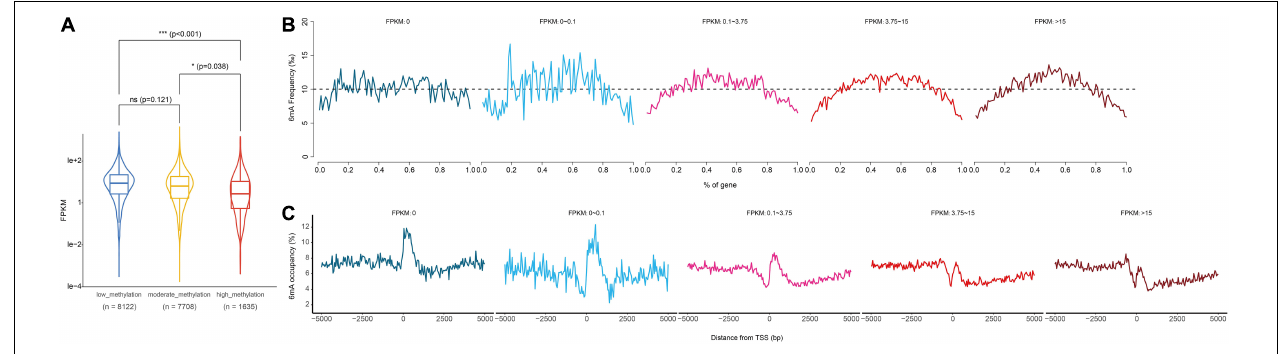
FIGURE 5 | Relationship between gene transcription and 6mA methylation. (A) Computational analysis of gene expression in different methylation levels genes. (B,C) Distribution of 6mA occupancy around the transcription start site in different methylation levels genes. * means statistical significant difference, *** means statistical extreme significant difference and p -value <